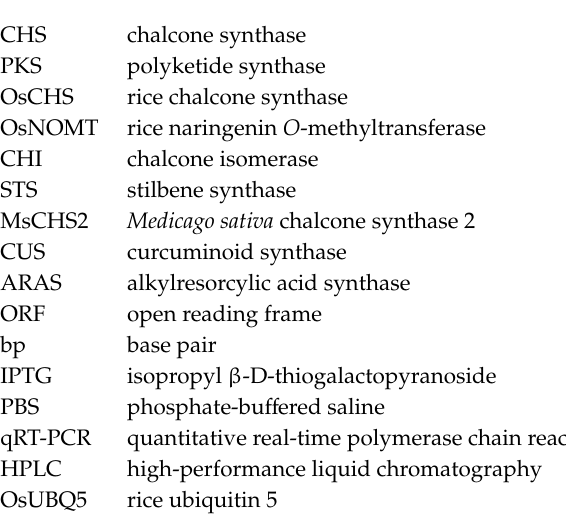
plant CHSs. Table S2. Primer sequences and PCR conditions for OsCHS cloning. Table S3. Primer sequences for quantitative real-time PCR